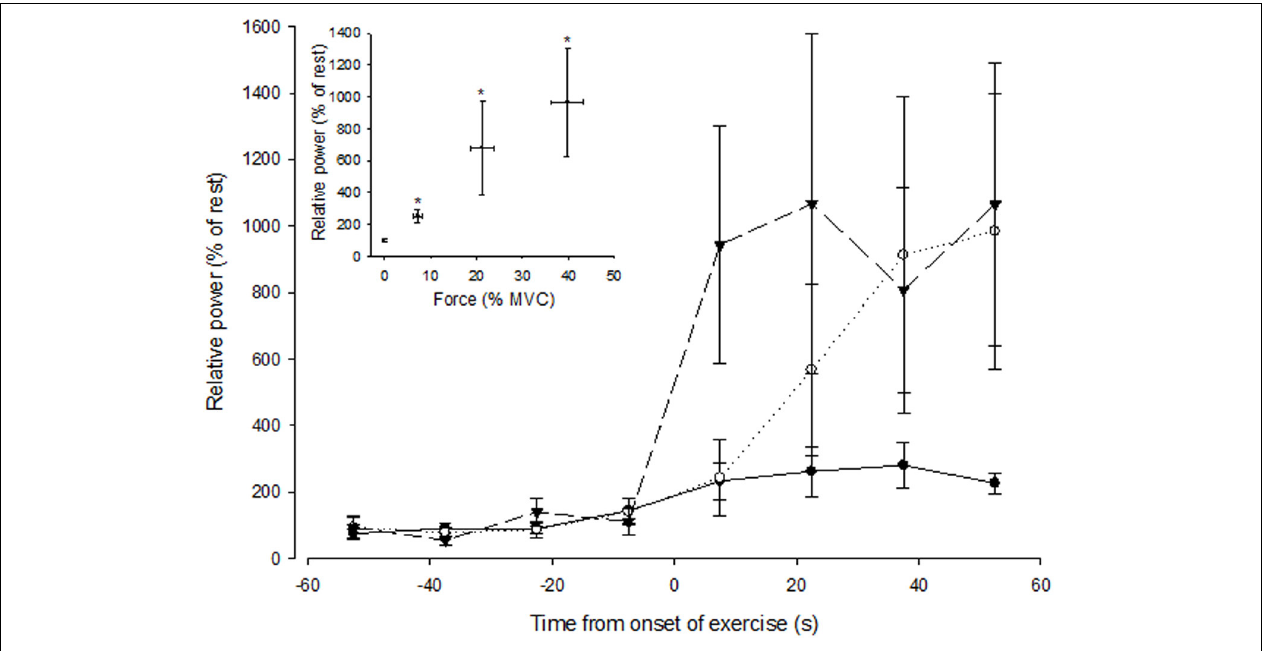
FIGURE 5 | Spectral power of MSNA (normalized to the resting value) during 15s intervals prior to and during the first minute of contraction at low (closed circle), medium (open circle), and high (triangle) forces.